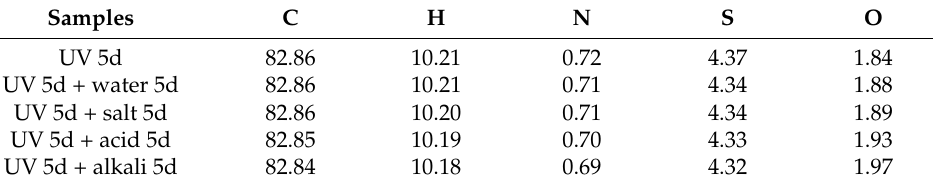
Table 5. Element content of asphalt after the multiple aging of UV and aqueous solution (%).